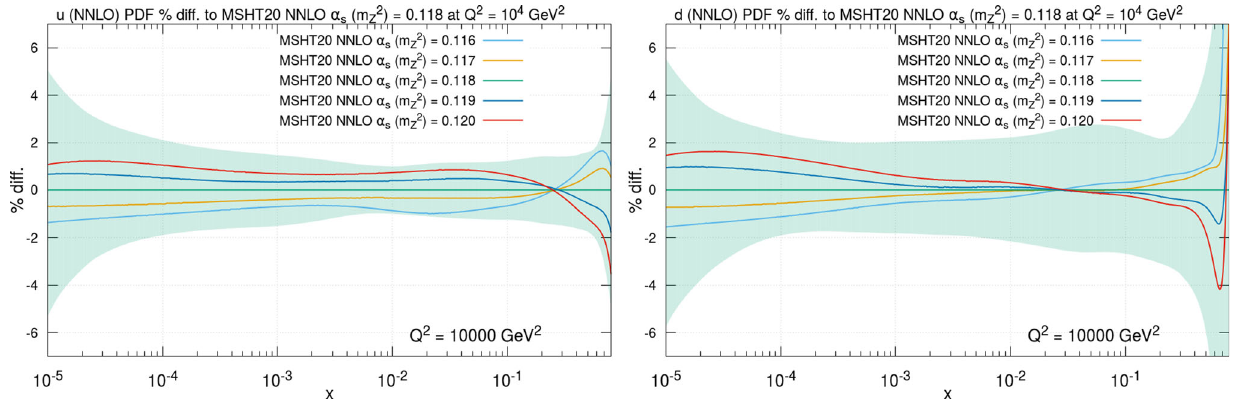
) = 0 . 118 ) set for fits with Z